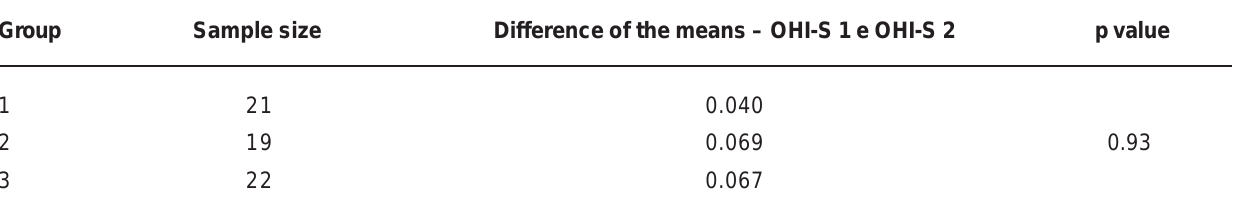
TABLE 3 - Differences of the means of the OHI-S indexes in the initial (OHI-S 1) and final stages (OHI-S 2) according to the groups in students aged 12 to 14 years. Piracicaba,